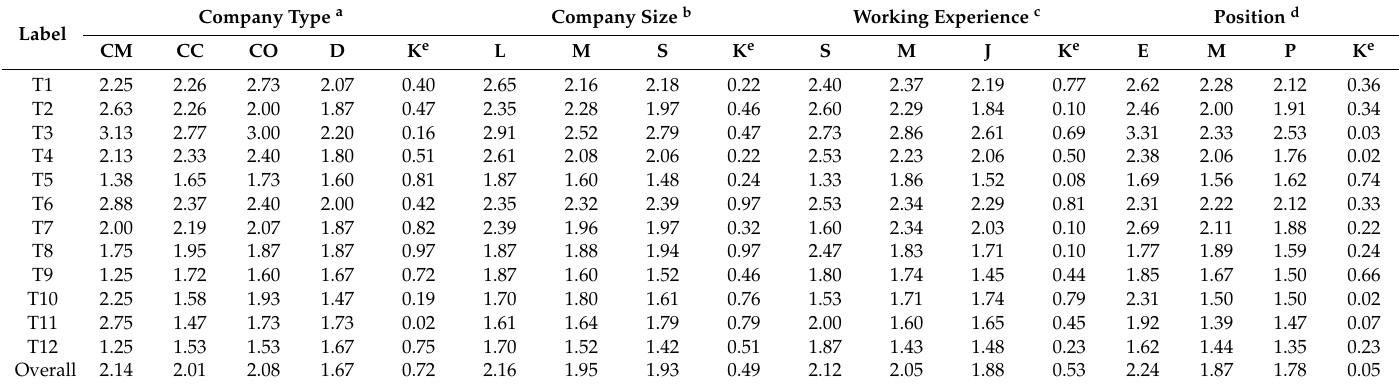
Table 4. Comparison of utilization level between di ff erent groups of respondents.